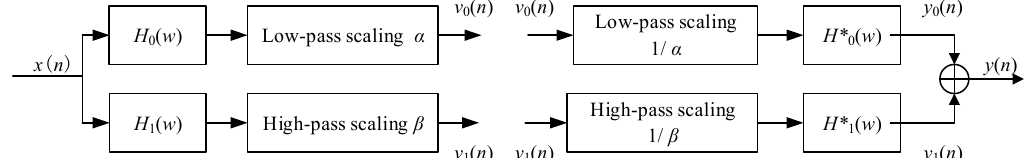
Figure 2. Analysis and synthesis filter banks for the dual-Q wavelet transform.